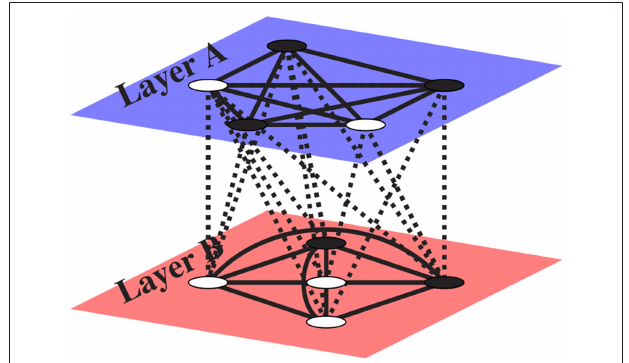
FIGURE 1 | Sketch of a two-layer network. The nodes are connected to each other in a pairwise manner both inside the layers (intralayer links) and across the layers A and B (interlayer links). Dotted lines describe the interlayer interactions and the solid lines describe the intralayer interactions. Black nodes stand for the agents playing strategy L, while white nodes stand for the agents playing strategy R in a coordination game.